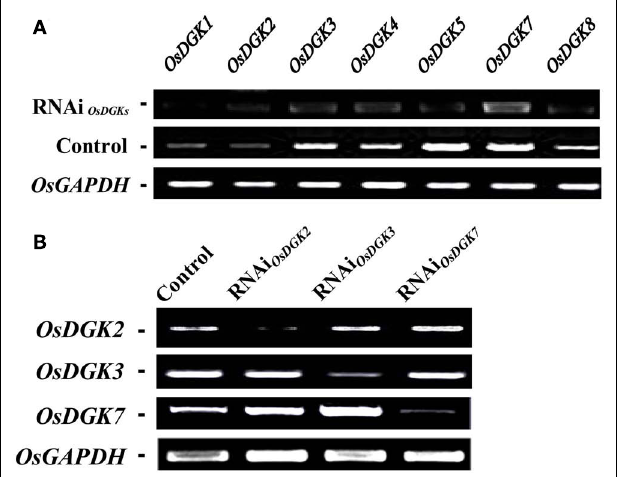
FIGURE 6 | Multi-gene and specific gene silencing of OsDGKs in protoplasts using transient RNAi. (A) Multi-gene silencing of OsDGKs in rice protoplasts using transient RNAi. RT-PCR analysis of OsDGKs was performed after transient RNAi by simultaneously introducing two in vitro -synthesized dsRNAs against conserved regions of OsDGK ( 1 , 2 , 3 , 7 ) and OsDGK ( 4 , 5 , 8 ). Mock-transfected (Control) and two dsRNA-transfected protoplasts (RNAi) were incubated for 24h, followed by protoplast collection for RNA isolation. OsGAPDH was amplified as an internal control. (B) Gene-specific silencing of OsDGKs in rice protoplasts with transient RNAi. RT-PCR analysis of OsDGK2 , OsDGK3 , and OsDGK7 was performed after transient RNAi using in vitro -synthesized dsRNAs against the 3 (cid:2) -UTR regions of each. dsRNA-transfected (RNAi) and mock-transfected (Control) protoplasts were incubated for 24h, followed by protoplast collection for RT-PCR analysis. OsGAPDH was amplified as an internal